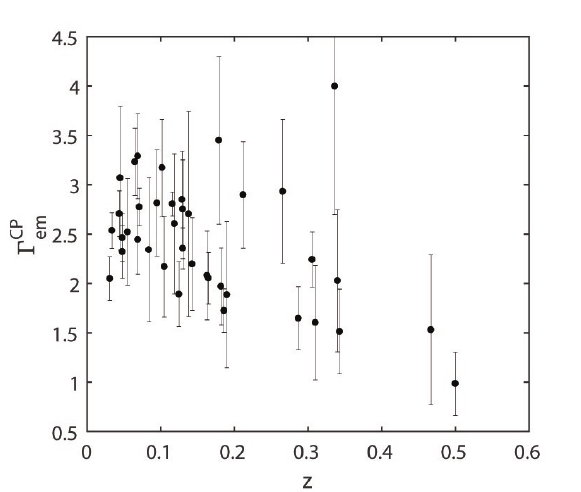
Figure 8. The values of the emitted spectral index Γ CP em with the corresponding error bars are plotted versus z for all blazars in S . (Credit [118]).